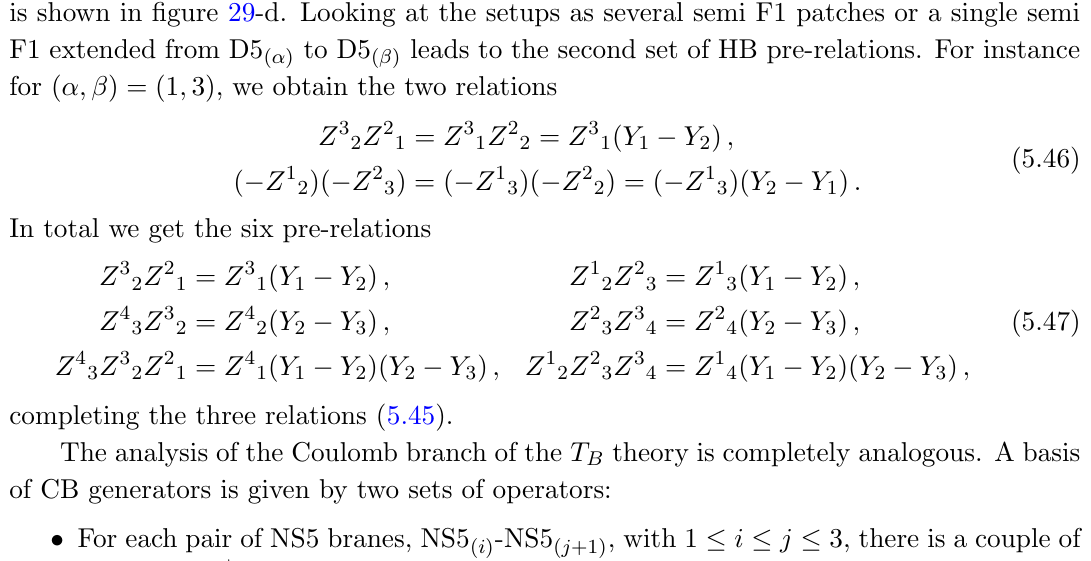
Figure 29 . Brane setups inserting the HB operators of theory A: a) Z 2 1 ; b) Y 3 ; c) Z 2 1 ( (cid:0) Z 1 2 ) or ( (cid:24) 1 (cid:0) Y 1 )( (cid:24) 2 (cid:0) Y 1 )( Y 2 (cid:0) Y 1 ); d) Z 4 3 Z 3 2 Z 2 1 or Z 4 1 ( Y 1 (cid:0) Y 2 )( Y 2 (cid:0) Y 3 ). The second set of con(cid:12)gurations have a semi F1 stretched between a pair of D5 branes, D5 -D5 , with (cid:11) +1 < (cid:12) , ending on the D3 segments from above or below. An example ( (cid:11) ) ( (cid:12) ) is shown in (cid:12)gure 29-d. Looking at the setups as several semi F1 patches or a single